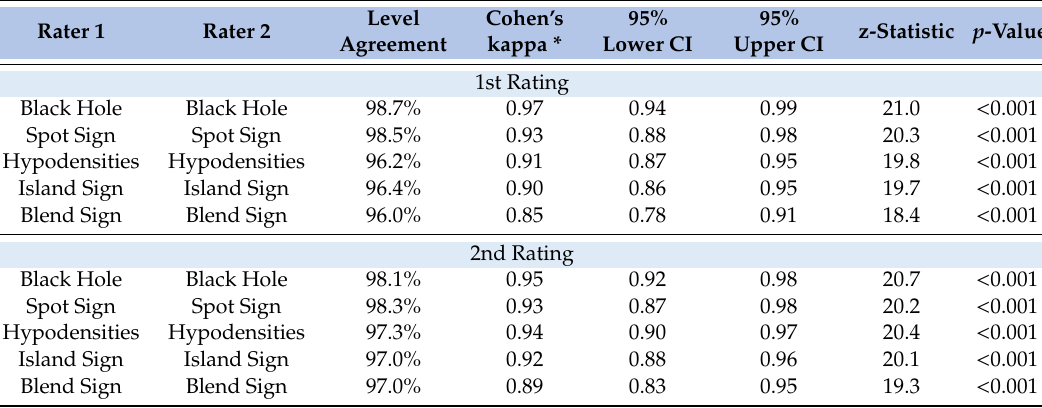
Legend: Interrater agreement of four noncontrast computed tomography imaging signs and spot sign on computed tomography angiography specified with percentage agreement and stratified kappa with 95% confidence interval (CI). * stratified Cohen’s kappa across two raters in two